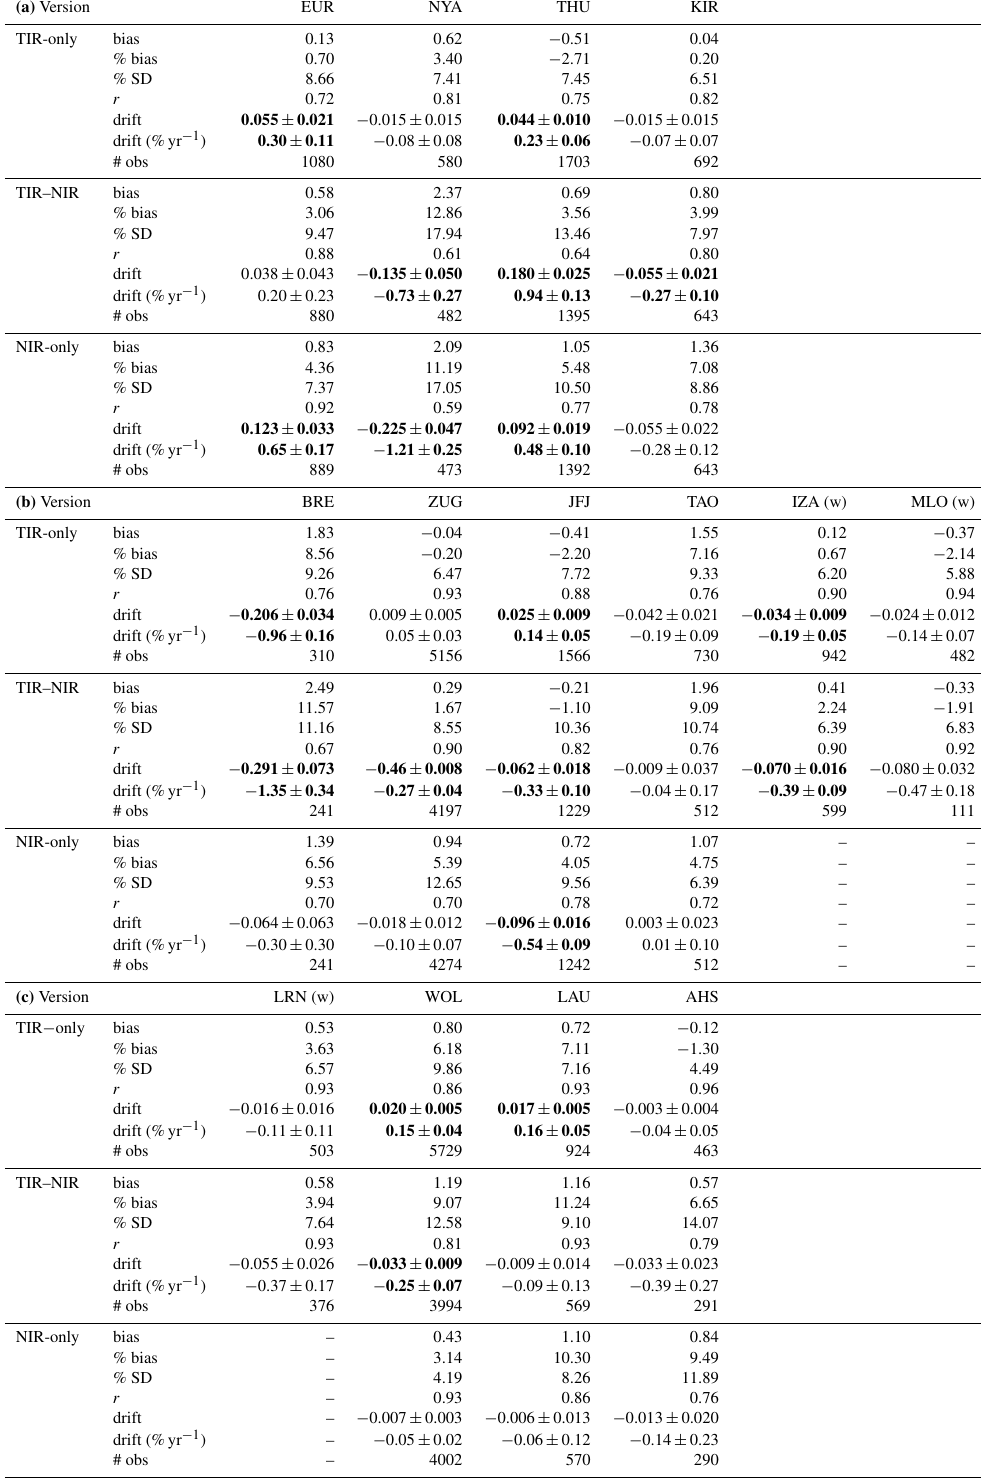
Table 3. (a) Site-wise validation results at Northern Hemisphere high-latitude stations. Mean bias (MOPITT–FTS) is expressed in units of 10 17 moleccm − 2 as well as percent relative to FTS values; units of drift are 10 17 moleccm − 2 yr − 1 or %yr − 1 , shown with standard error. Bold text indicates significant drift where p < 0 . 01, determined from a two-tailed t test. (b) Same as (a) but for Northern Hemisphere low- and mid-latitude sites. Results are for land pixels, except where the majority of pixels are water (w). (c) Same as Table (b) but for Southern Hemisphere